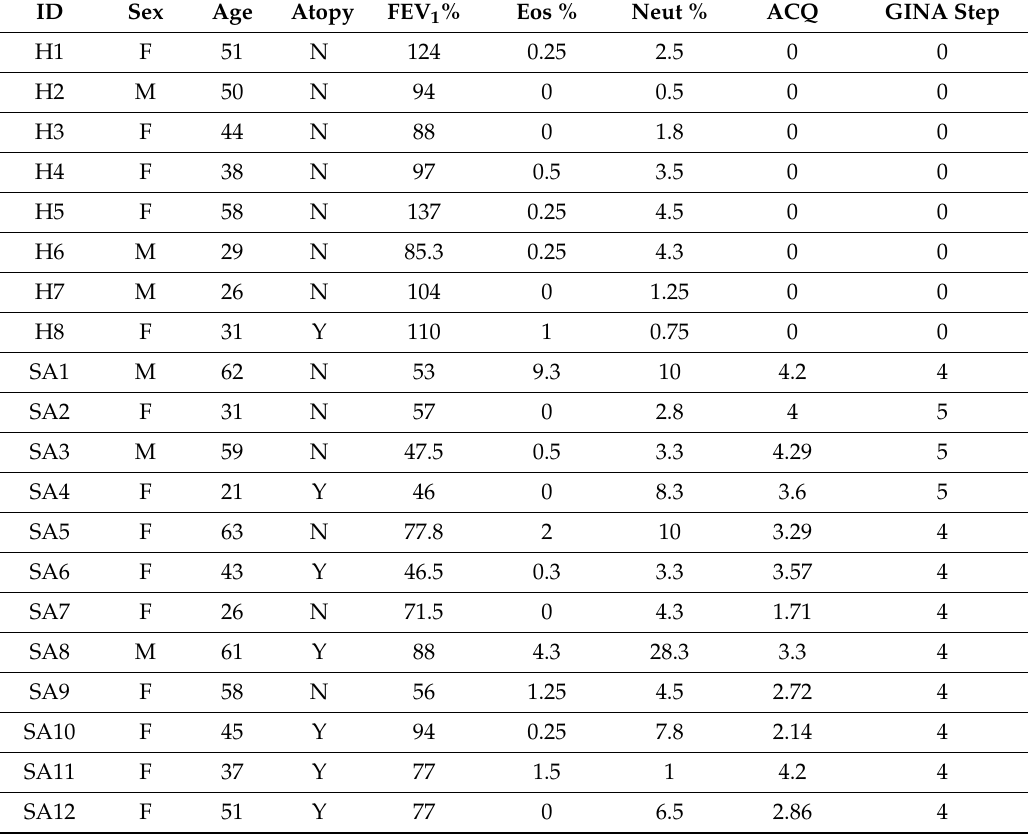
Table 1. Subject characteristics. F: Female. M: Male. FEV 1 %: forced expiratory volume in 1 s percentage of predicted. Atopy was defined as at least one positive skin prick test response to aeroallergens with testing for Aspergillus fumigatus, Alternaria taenia, mixed grass pollen, birch pollen, mixed tree pollen, oil seed rape polen, Dermatophagoides pteronyssinus, Dermatophagoides farinae , feathers, and animal allergens (cat, dog, horse, and rabbit). ACQ = Asthma Control Questionnaire. Cell percentages (Neutrophils [Neut] and Eosinophils [Eos]) related to Bronchoalveolar lavage (BAL) di ff erential cell counts.